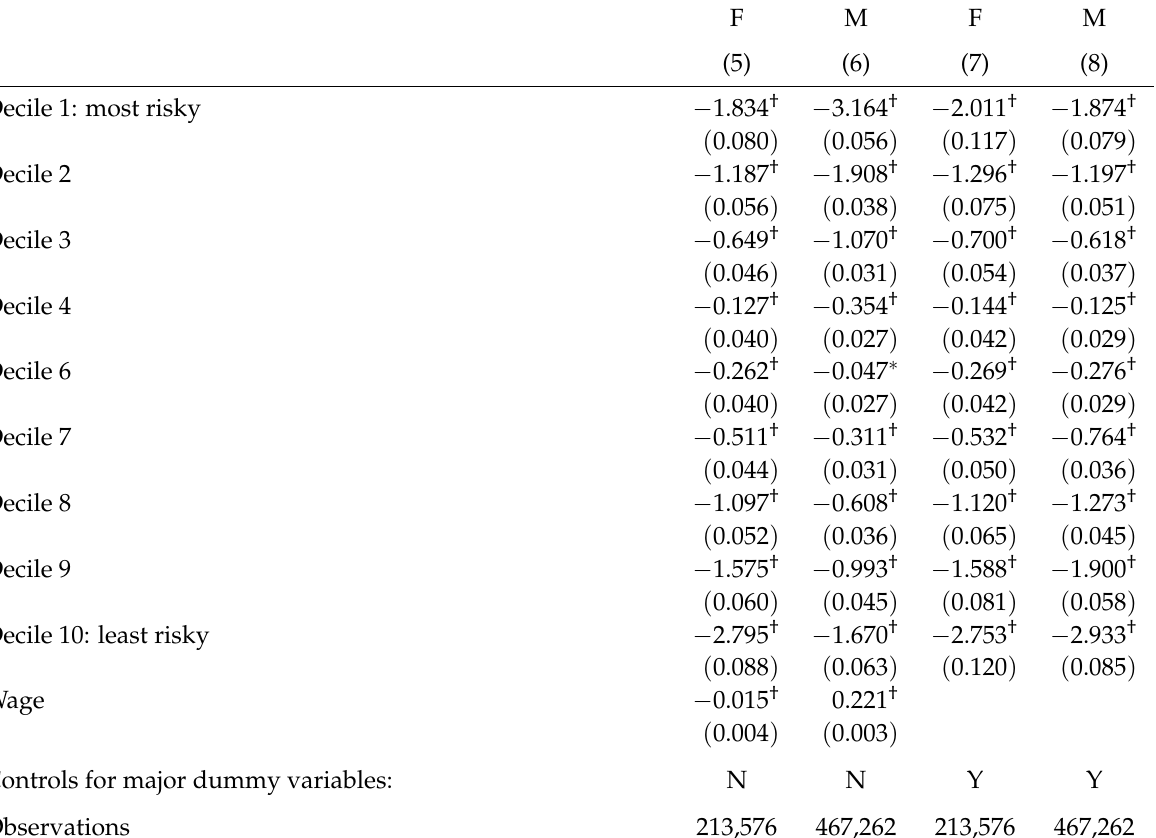
Table 4B: Multinomial Preferences Model: Effects of Expected Wage and Difficulty of Being Accepted, by Gender, on the Second Choice,